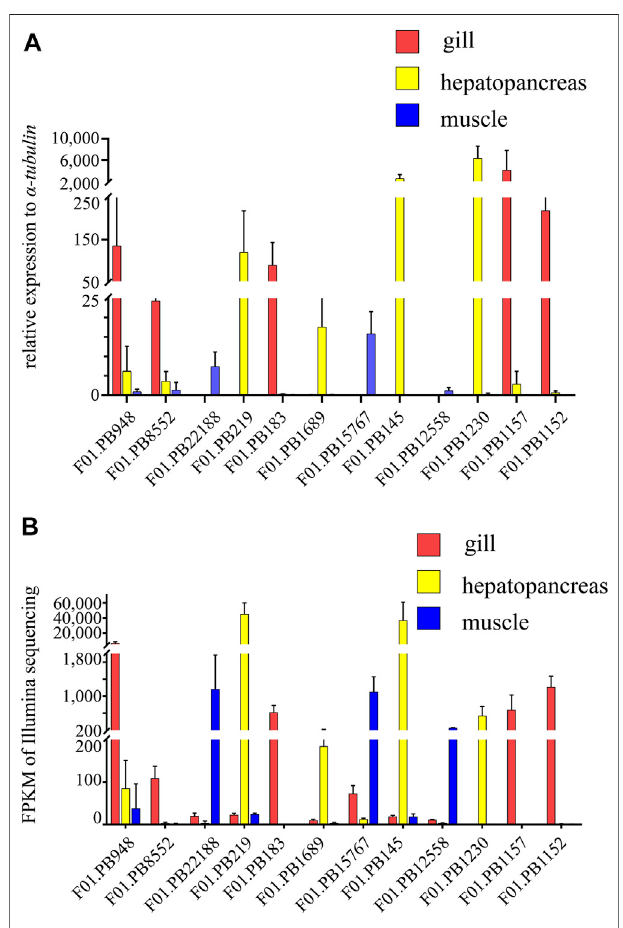
FIGURE 9 | The relative expression levels and FPKM of selected twelve genes. (A) Relative expression levels of selected twelve genes in three tissues of G. erosa by qRT-PCR. 2 − ΔΔ Ct values (normalized to housekeeping gene α - tubulin ) represented the expression of genes in three tissues (gill, hepatopancreas and muscle) of G. erosa . (B) Graphical representation of FPKM value of the twelve genes from Illumina sequencing results. Bars represent the average results of triplicate reactions for each tissue. Error bars representstandard errorofthe mean(SEM) among threebiological replicates.